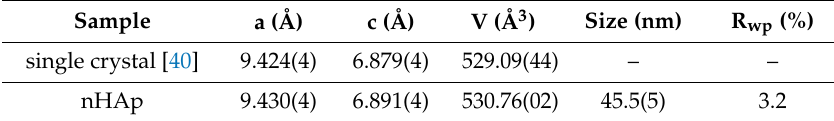
Table 1. Unit cell parameters (a, c), cell volume (V), crystallite size, and refine factor ( R wp ) for the